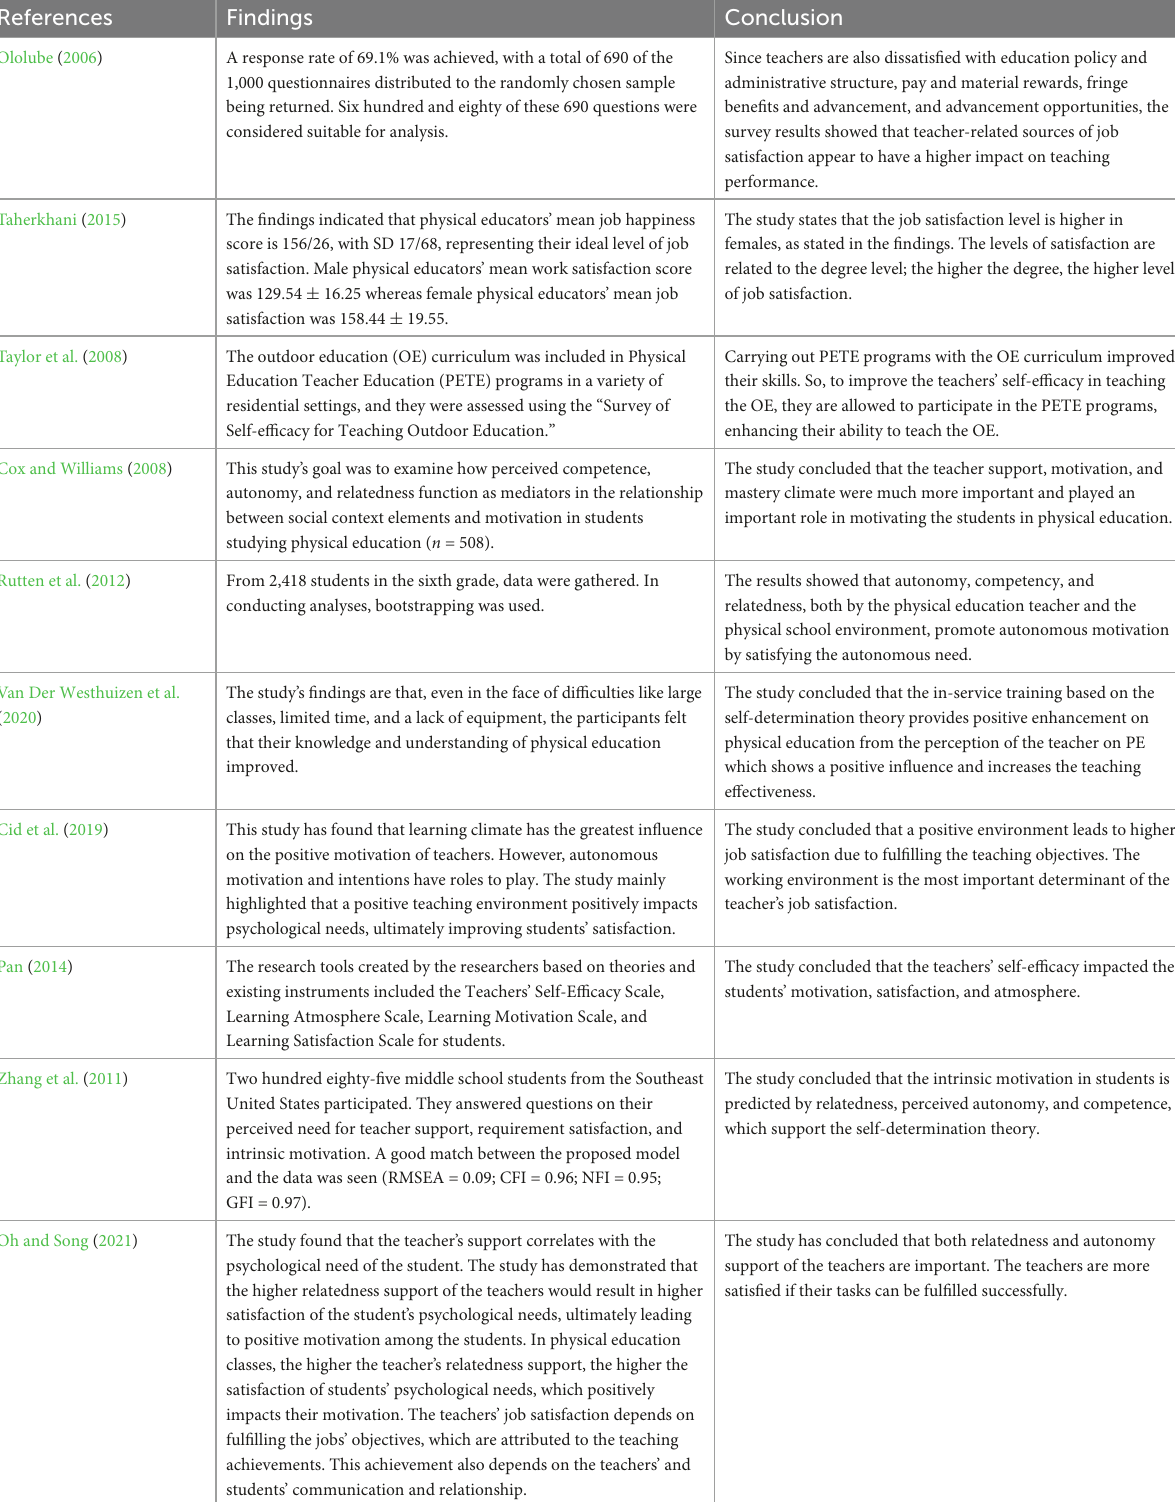
TABLE 2 Summary of findings and conclusion of included studies in this